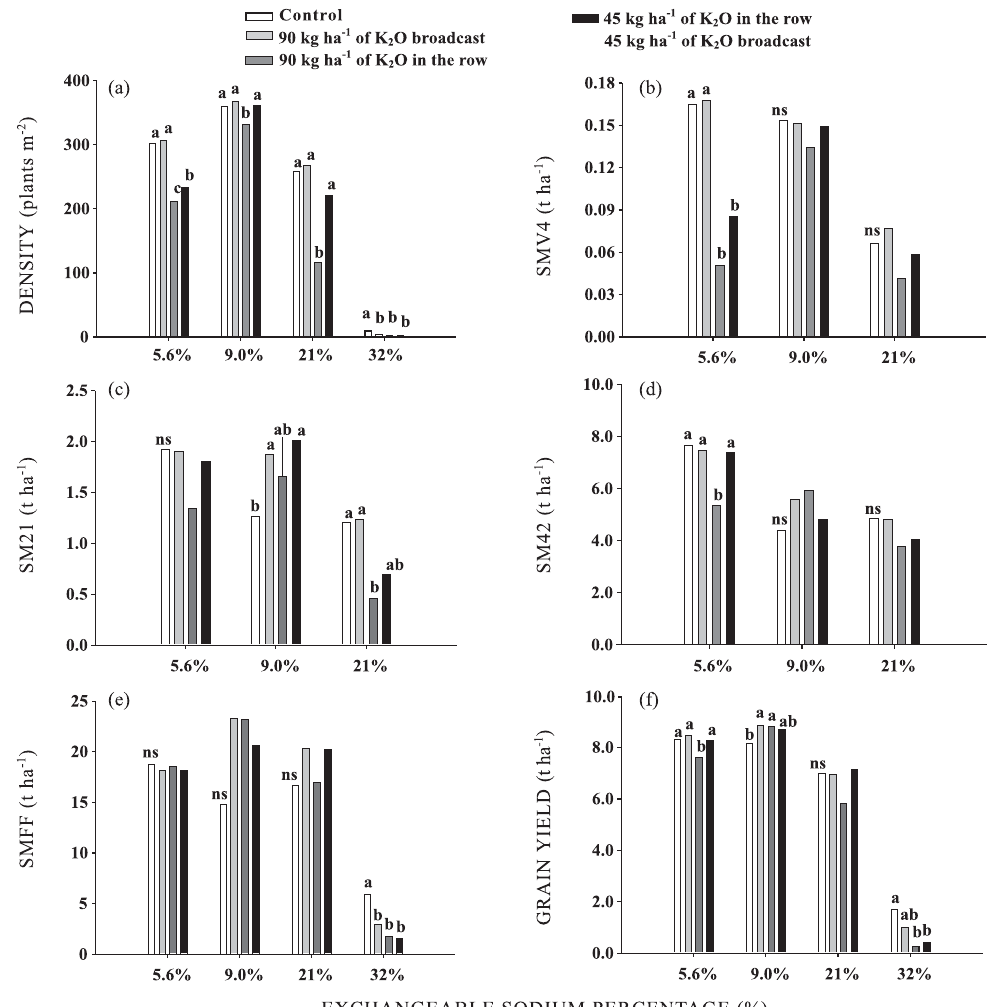
Figure 2. Density (a), shoot mass in V4 (b), shoot mass 21 DAF (c), shoot mass 42 DAF (d), shoot mass at full flowering (e) and grain yield (f) of irrigated rice plants according to potassic fertilizer management and soil sodicity level. Means followed by the same letter, between the sodicity levels do not differ by LSD test at 5